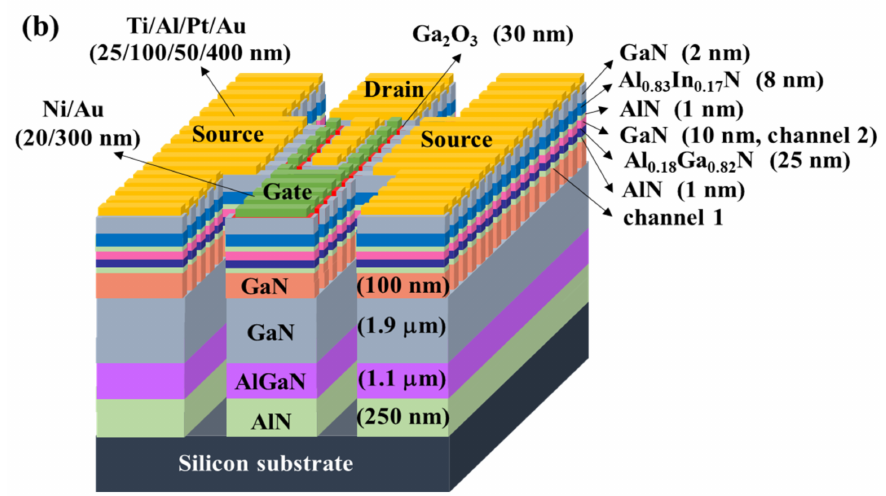
Figure 1. Epitaxial structure and three-dimensional schematic configuration of double-channel MOSHEMTs with ( a ) planar channel and ( b ) multiple-mesa-fin-channel array.